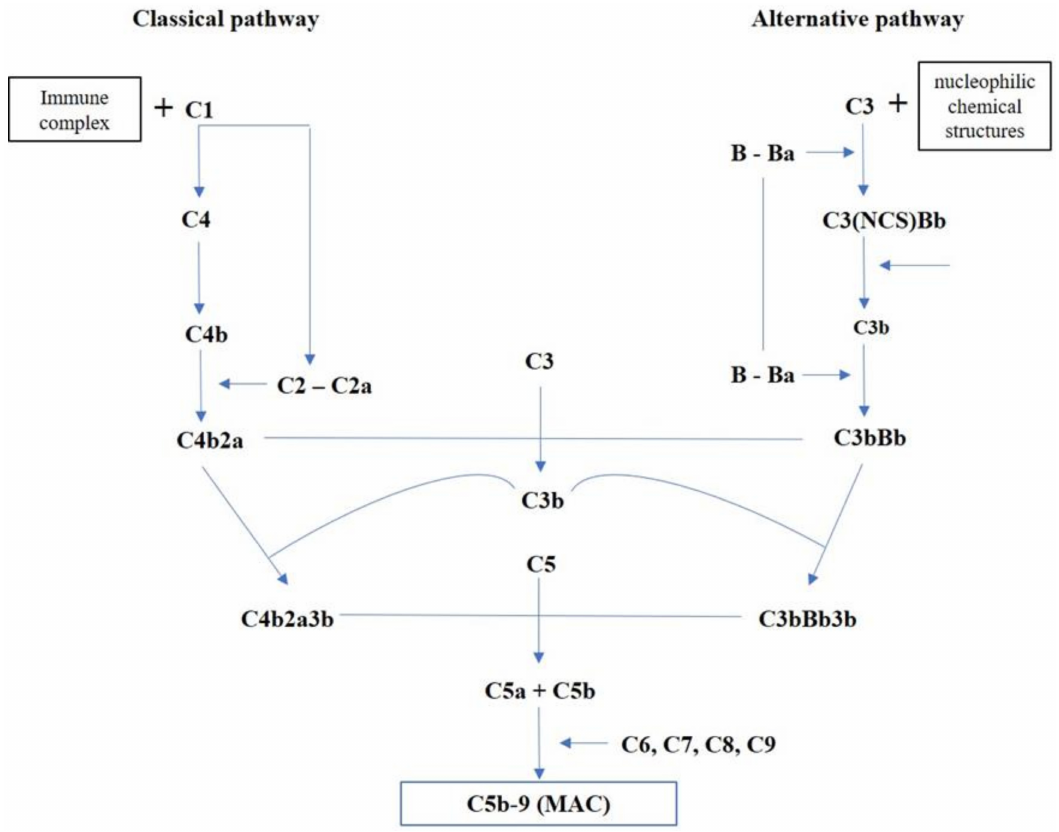
Figure 1. Overview of complement activation